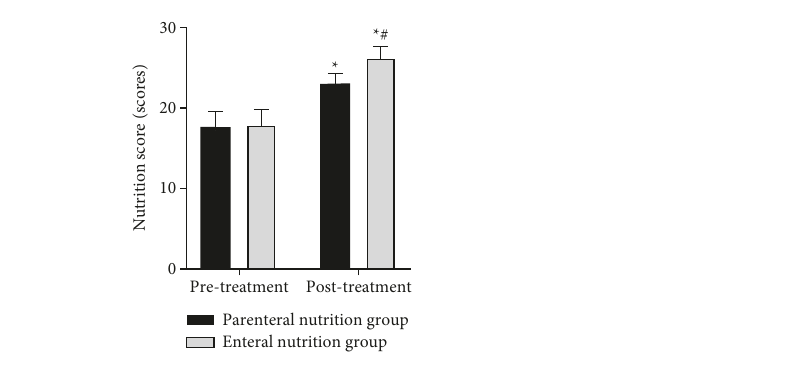
Figure 6: Comparison of nutritional scores between the two groups. the parenteral nutrition group after treatment. There is a statistical difference.